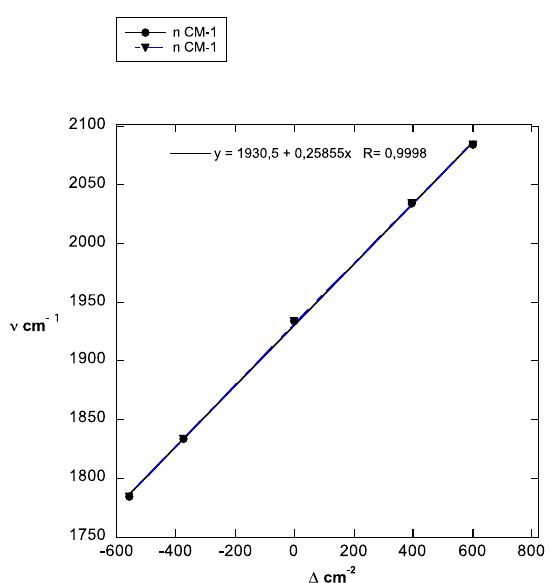
Figure 3. Plot of the data of Table 2, showing a correlation coefficient very close to R = 1. Table 2. Calculated values of ∆ (cm − 2 ) for a series of vibrations ν cm − 1 . ν cm − 1 1784 1834